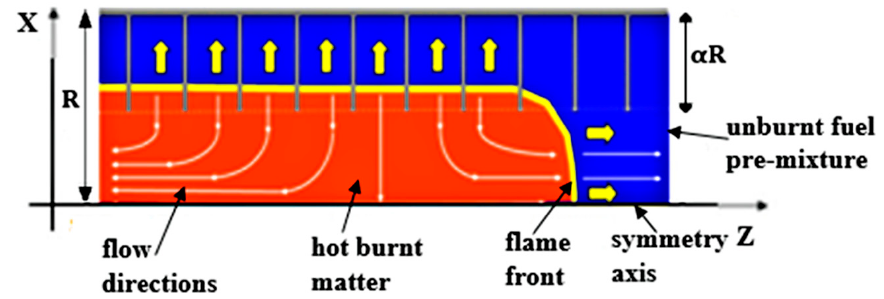
Figure 1. A schematic of an obstructed channel with both extremes open (upper half is shown).